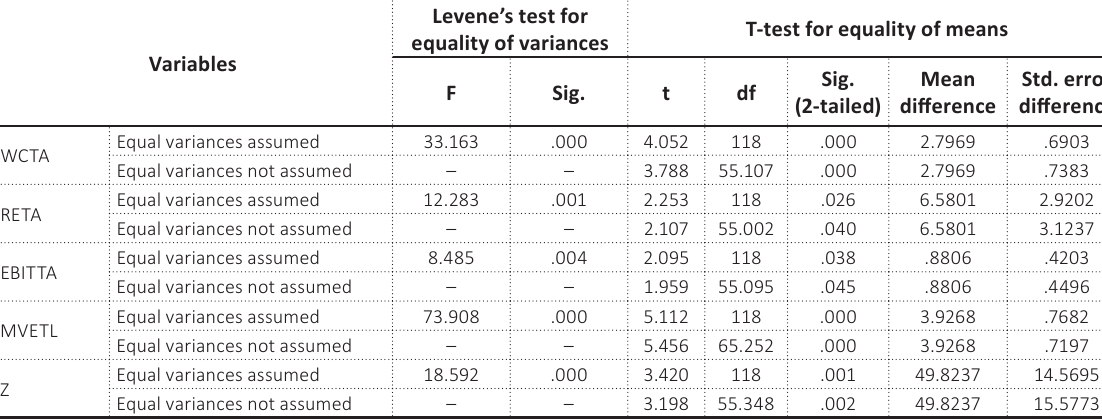
T-test for equality of